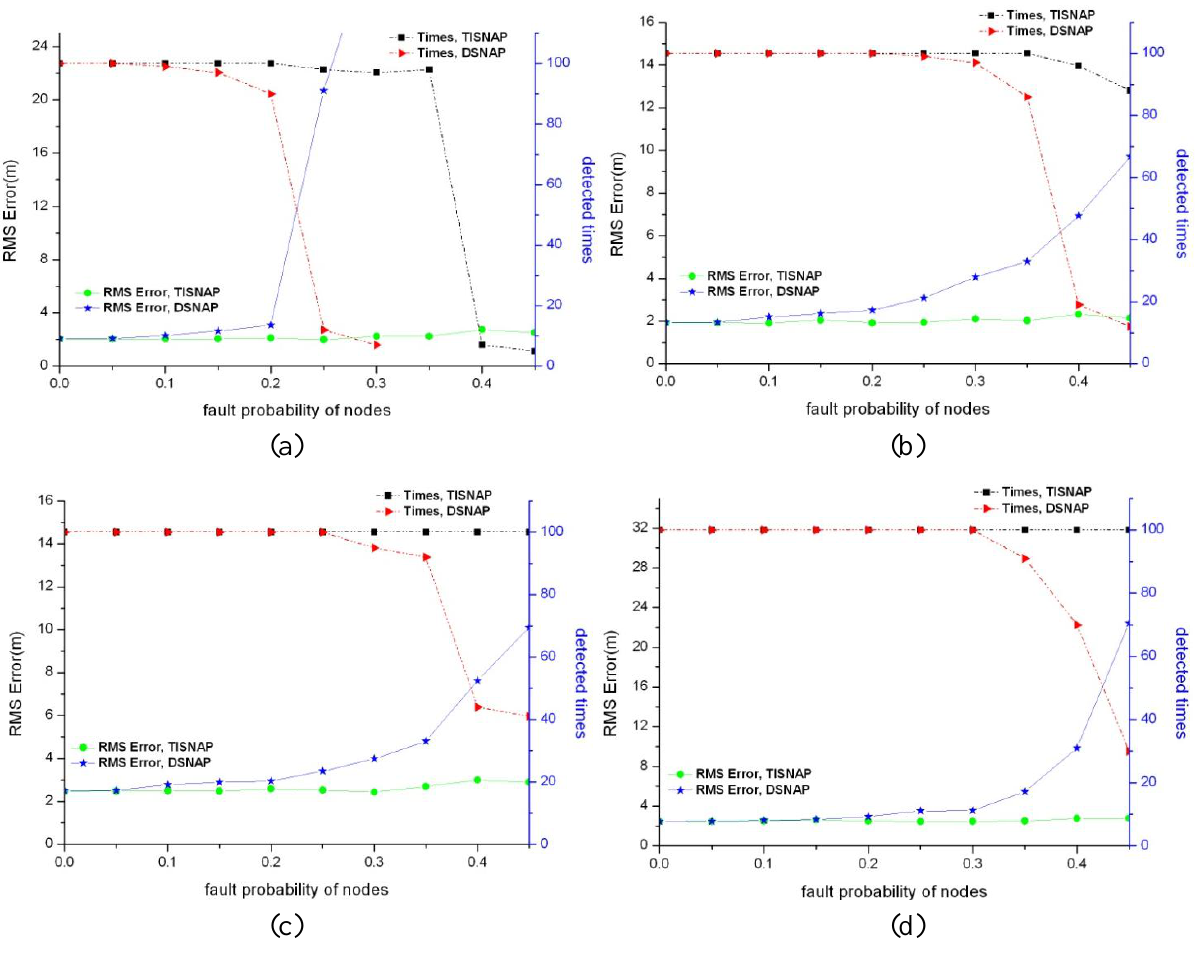
Figure 6. Fault tolerance performance for different signal strength of event